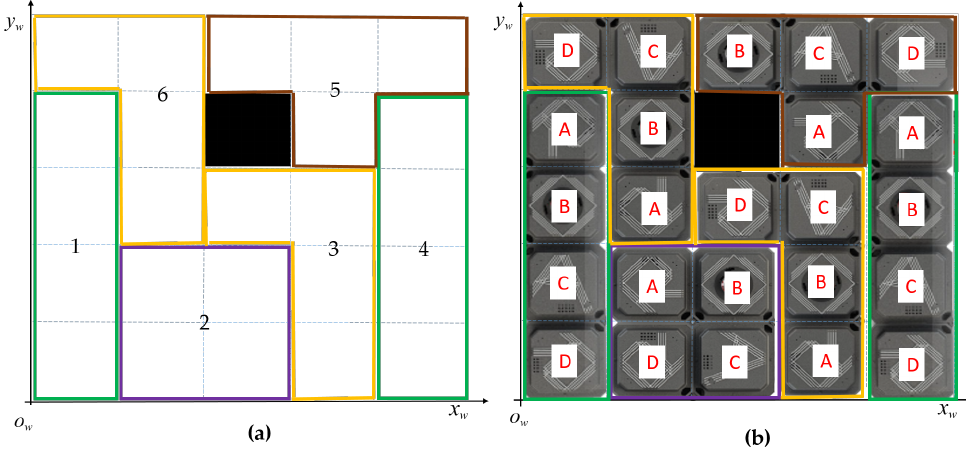
Figure 7. hTtro covers the workspace by tilsetset. ( a ) workspace of 5 × 5 ( b ) tileset, ( b ) hTetro heading orientation and block position in the